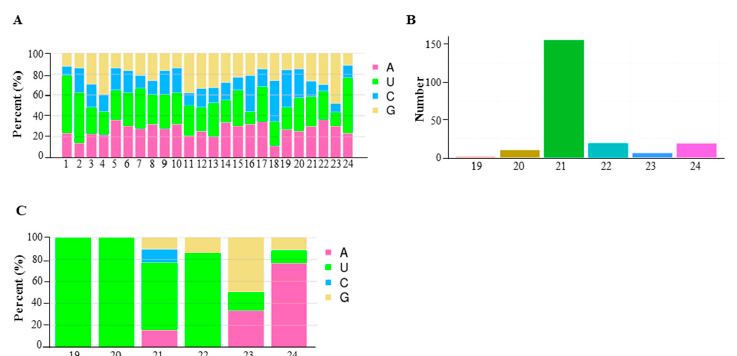
Figure 6. Nucleotide preference of small RNAs in B. napus showing ( A ) nucleotide preference at each position; ( B ) number of 19- to 24-nucleotide (nt) small RNAs in all the identified small RNAs and ( C ) the first nucleotide bias of 19- to 24-nucleotide (nt) small RNA. Examination of miRNA expression dynamics in 6098B and Purler identified 45 and 65 differentially expressed miRNAs at the two developmental stages, respectively (Figure 7A, Tables S6